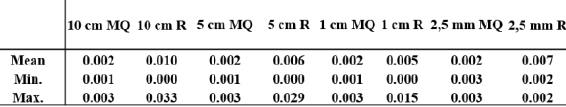
Table 3. σ 0 of plane estimated with RANSAC and with least square